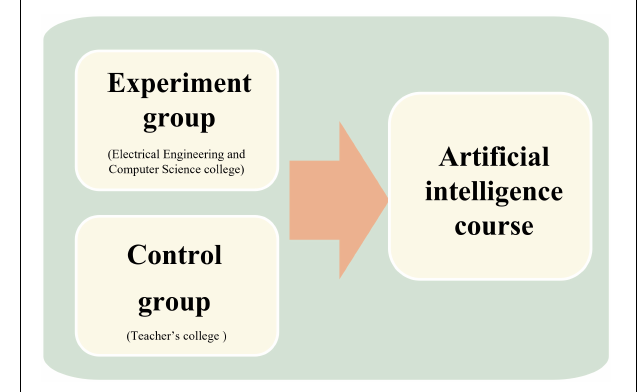
FIGURE 1 | Research participants in the artificial intelligence (AI)